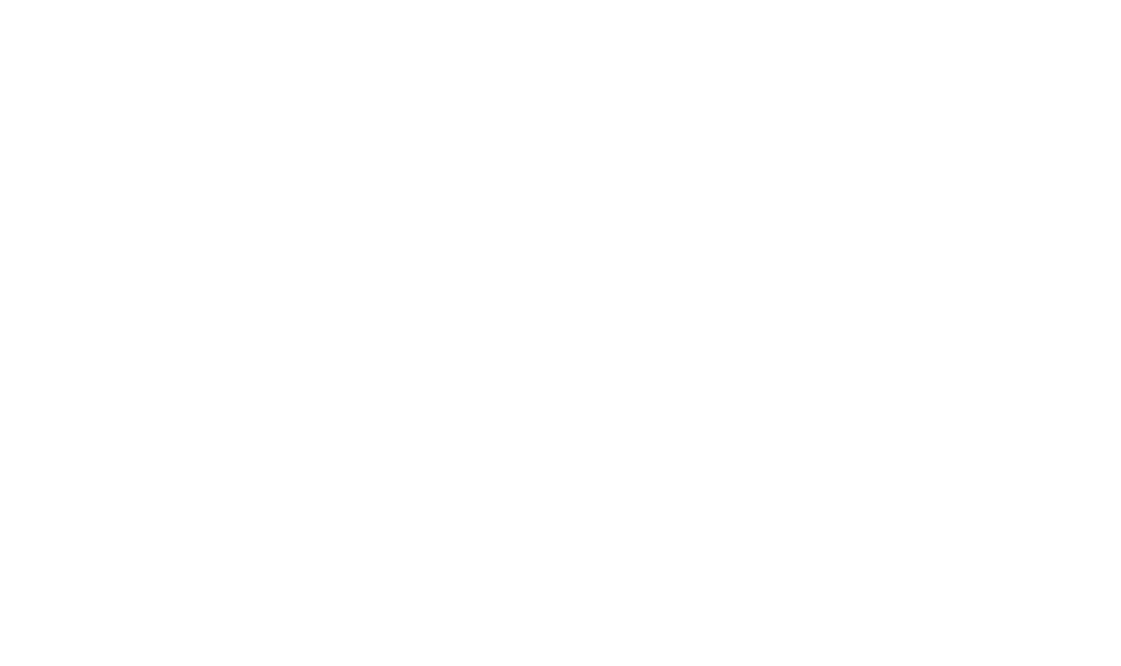
Frontiers in Ecology and Evolution |